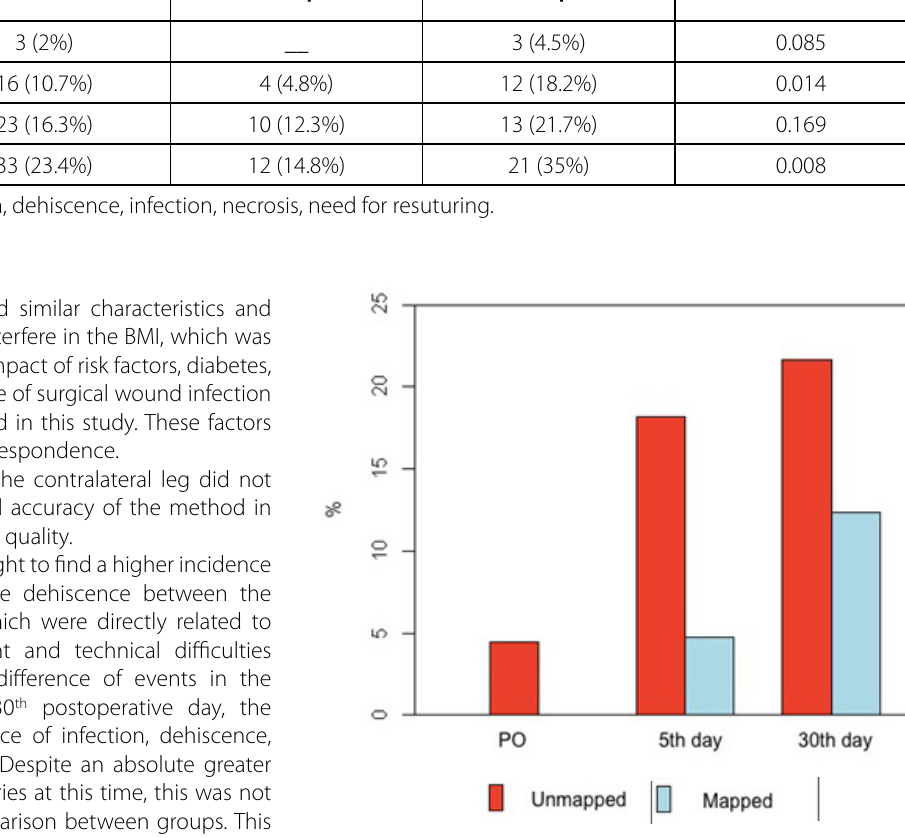
Fig. 1 – Frequency distribution bar graph of complications in groups of patients with and without mapping in the immediate postoperative period, with 5 and 30 days.